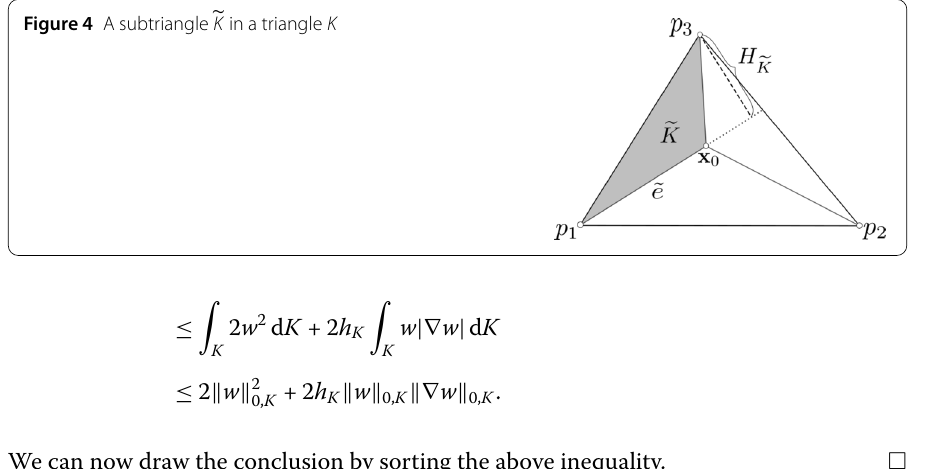
Figure 4 A subtriangle (cid:17) K in a triangle